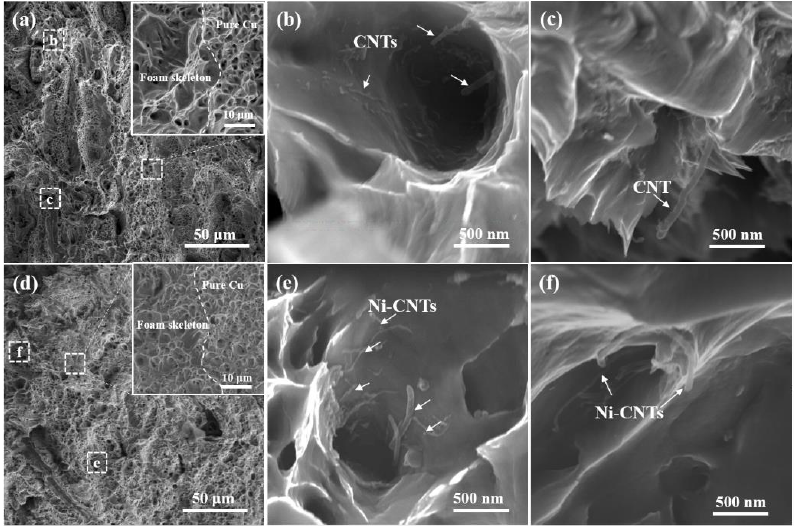
Figure 8. Fracture morphology observation: ( a ) CNTs/Cu f® Cu composite; ( b , c ) enlarged images in the corresponding area of ( a ); ( d ) Ni-CNTs/Cu f® Cu composite; ( e , f ) enlarged images in the corresponding area of ( d ). The inset shows the magnified images of the selected areas. Table 2. Tensile properties and conductivities of composites prepared in this study and the litera- ture.